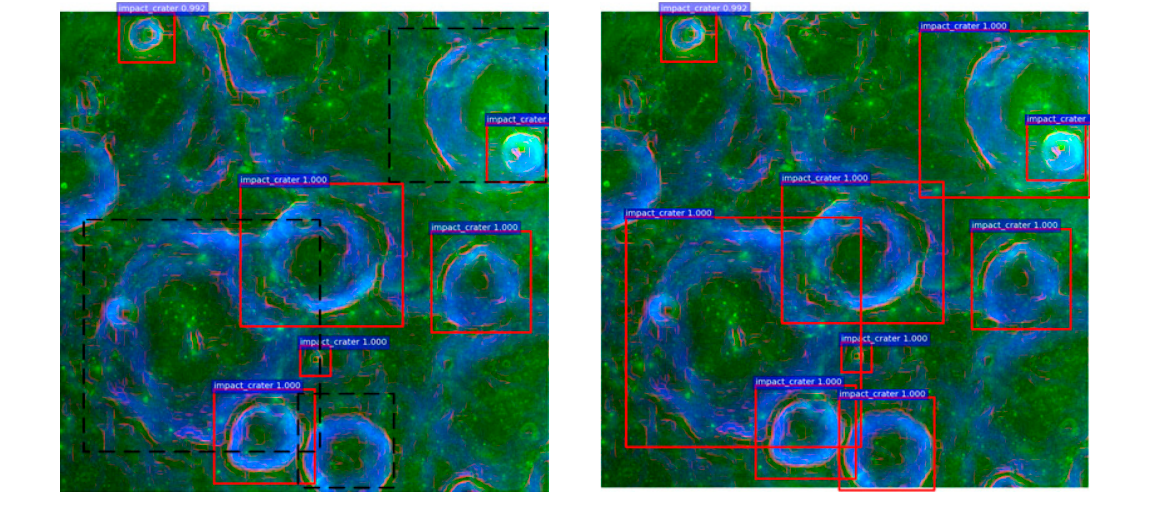
Figure 7. Comparison of NMS and Soft-NMS algorithms.